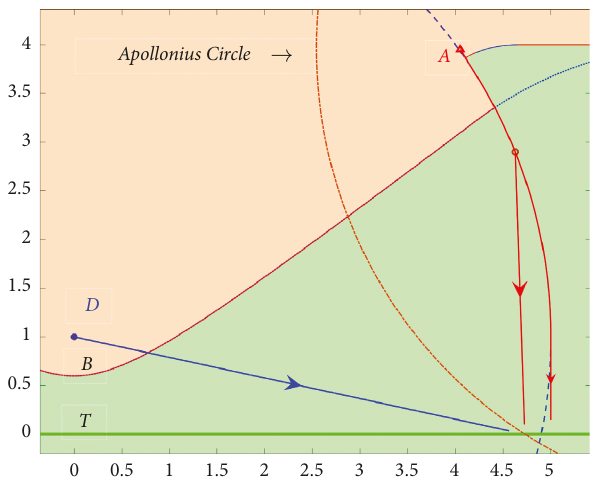
Figure 19: The numerical simulation of the barrier related to equation (68) when A is inside